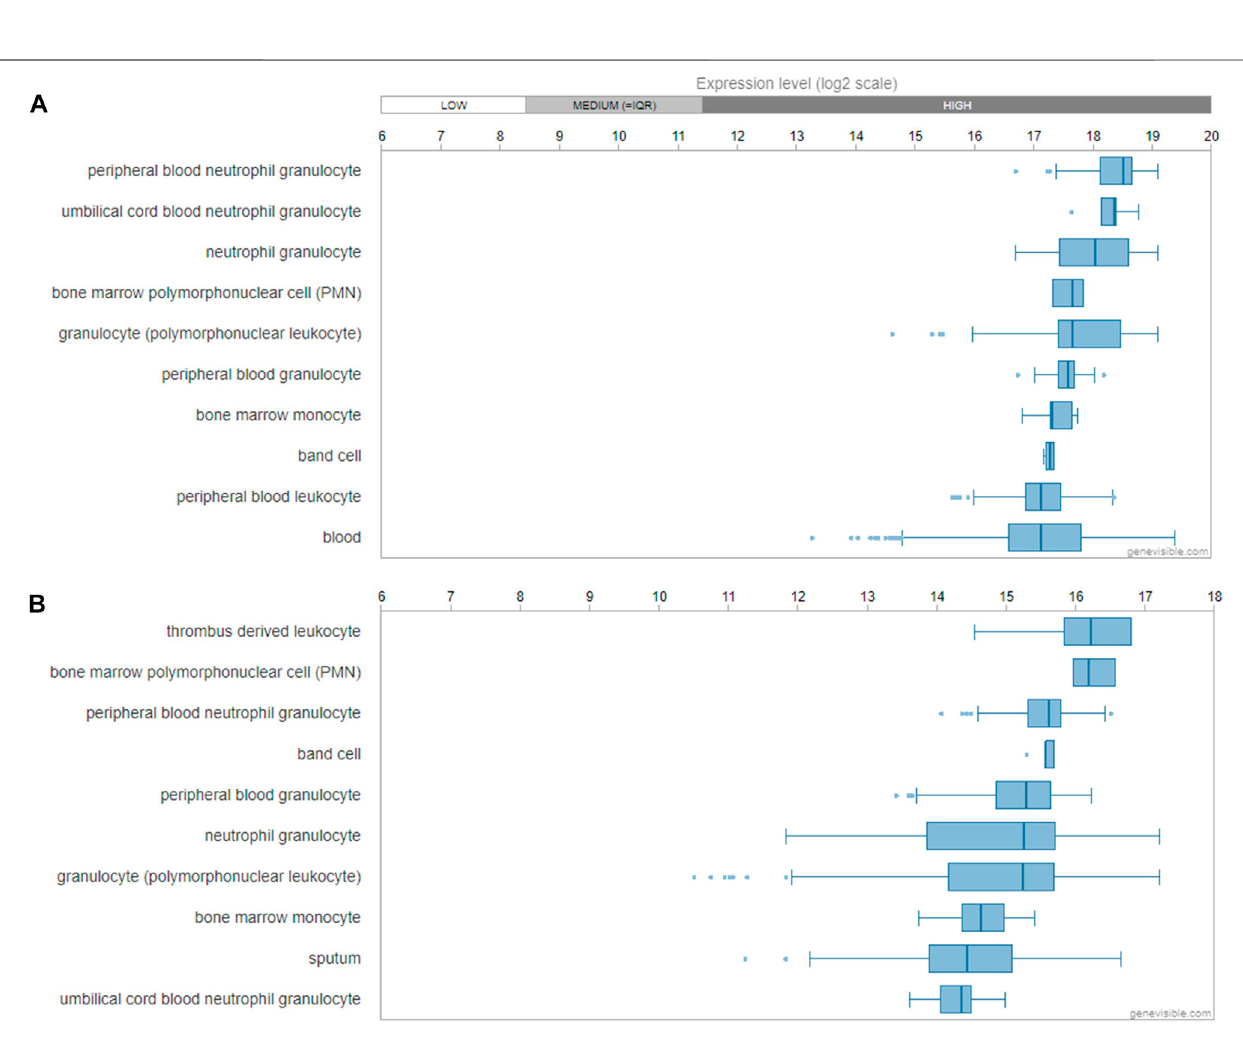
Frontiers in Cell and Developmental Biology |